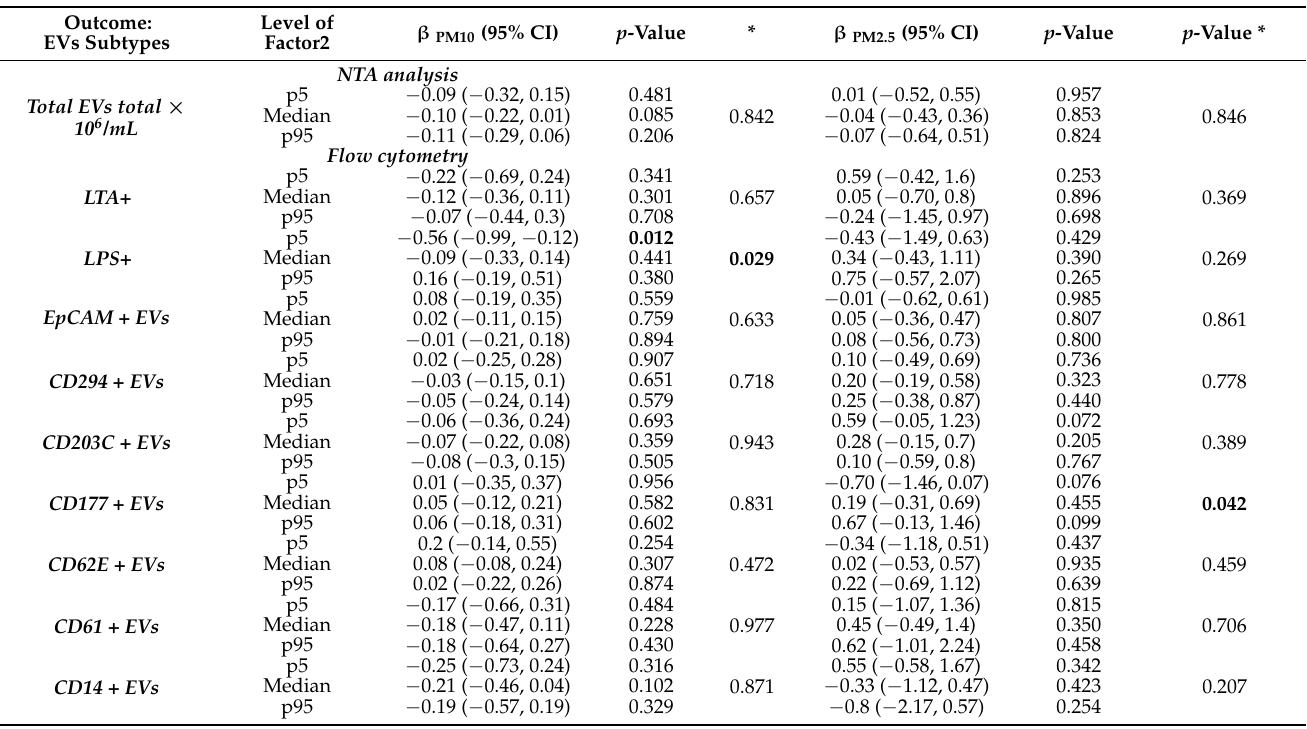
Table 8. Association between PM and EVs subtypes for the selected values of Factor2, which is characterized by the greatest positive loadings on Anaerococcus, Acinetobacter, Peptoniphilus, and